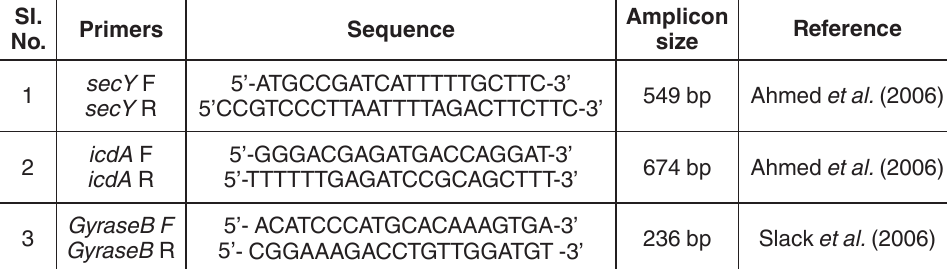
table 1. Primer sequence used for MLST analysis si. No.